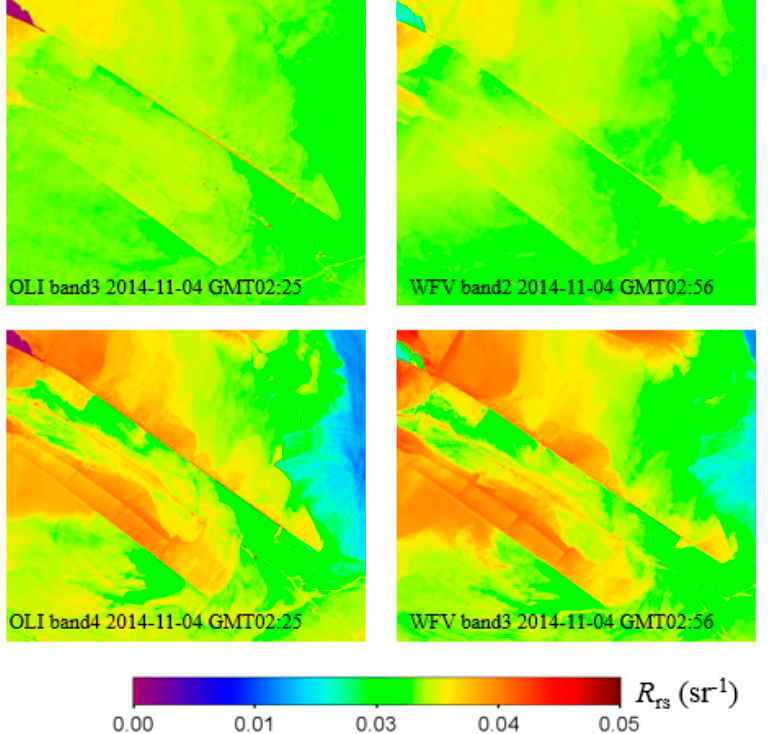
Figure 9. The R rs image of deep water channel retrieved by OLI image using SWIR method [10] and by WFV image using our method. Upper two figures corresponding to green band and lower two figures to red band.